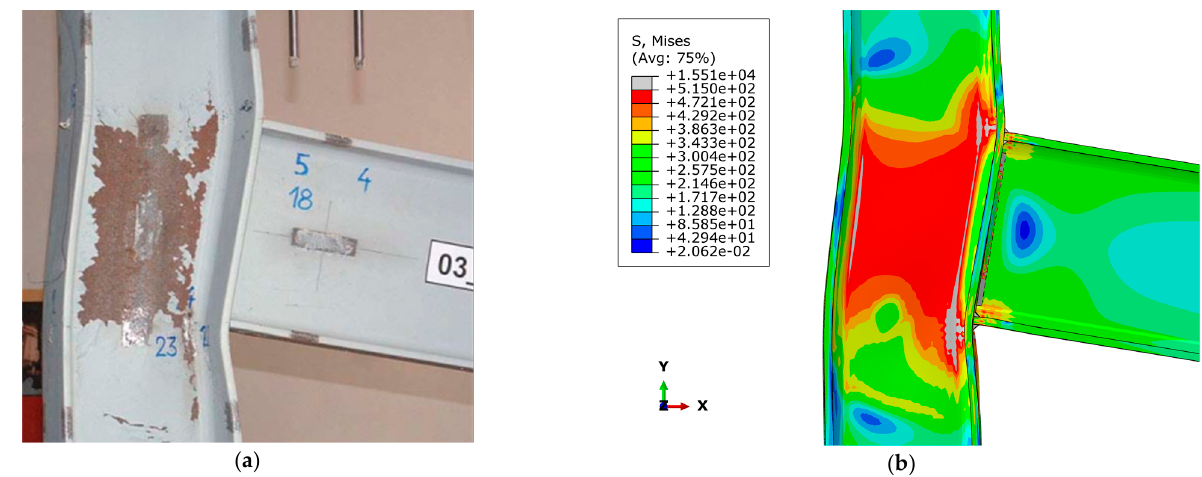
Figure 8. Failure mode of steel beam-to-column welded joint: ( a ) experimental [27], ( b ) numerical.